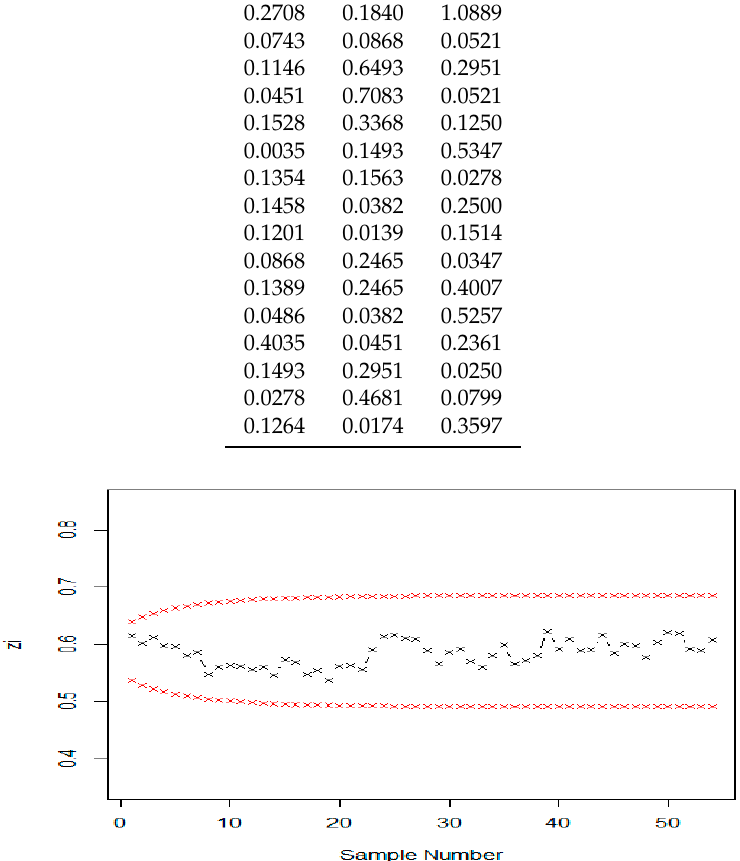
Figure 5. Graph of real data of the proposed EEWMA control chart when ψ 1 = 0.10, ψ 2 = 0.03, k = 2.8248, r 0 = 500.